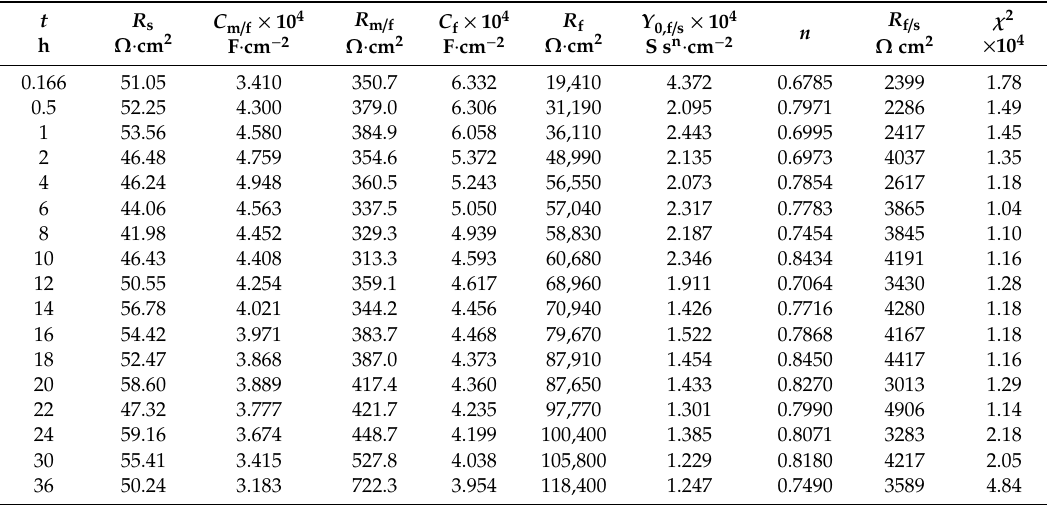
Table 1. The EIS fitting parameters obtained by using the equivalent circuit for TC11 alloy in 0.01 M Na 2 SO 4